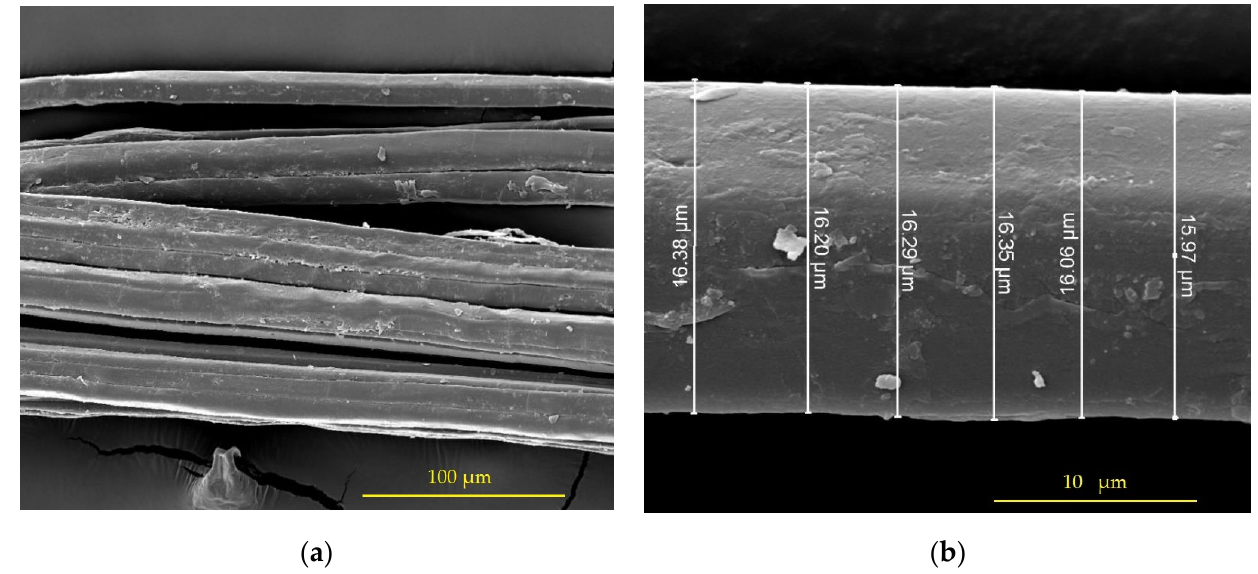
Figure 5. Scanning electron microscopy (SEM) in the hemp sample: ( a ) bundle of fibers, 1000 × ; ( b ) measurements of a fiber, 10,000 × .